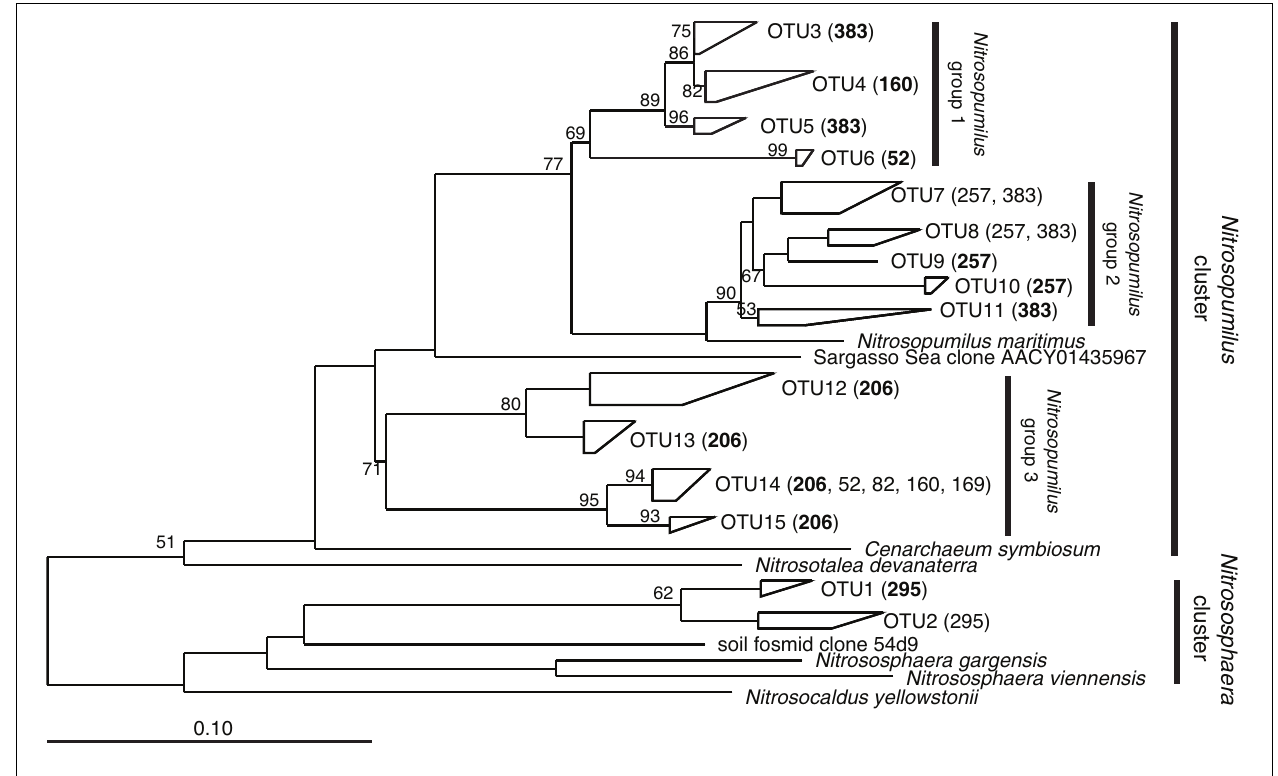
shown at the internal nodes. Each polygon represents sequences from a single OTU with theTRF sizes of the sequences (number of base pairs determined in silico ) indicated parenthetically.TRF sizes representing ≥ 85% of the sequences in the cluster are shown in bold.